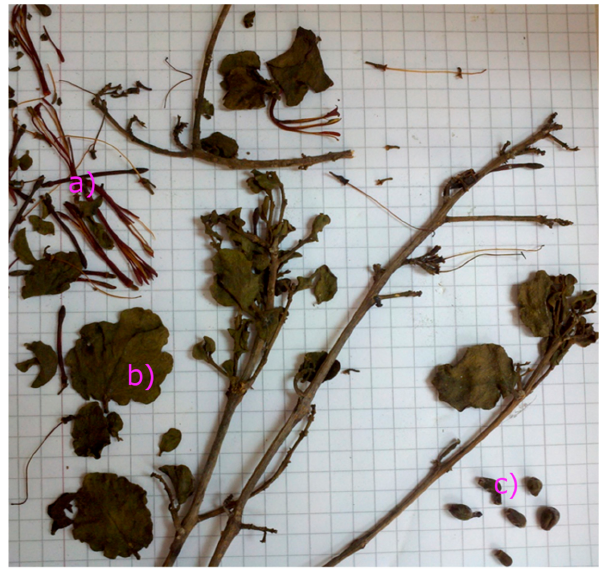
Figure 1. Pictures of an herborized sample of T. tetrandus collected in the VIII region of Chile in 2012. ( a ) Flowers; ( b ) leaves; ( c ) fruits.